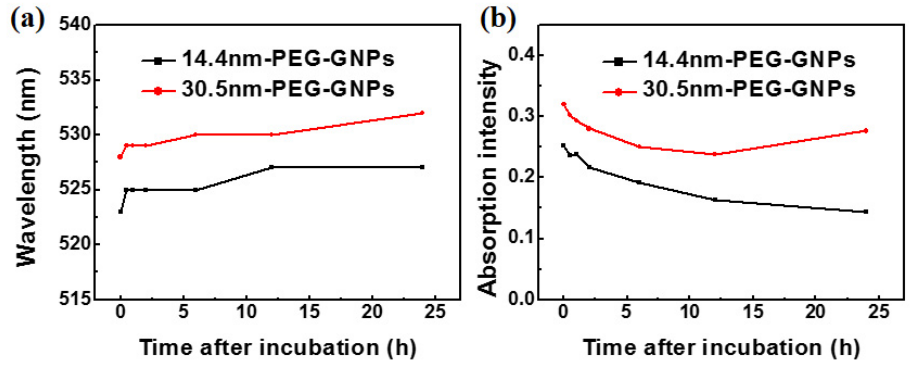
Figure 3. Time-dependent surface plasmon resonance (SPR) peak ( a ) and intensity ( b ) of 14.4 and 30.5 nm PEG-coated GNPs on blood plasma.